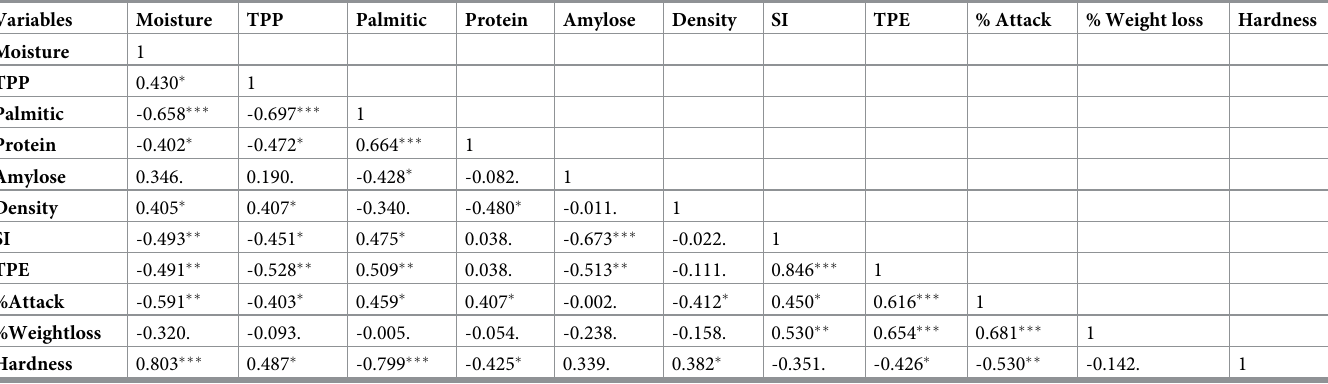
Table 4. Spearman correlation matrix between physical, biochemical and varietal susceptibility